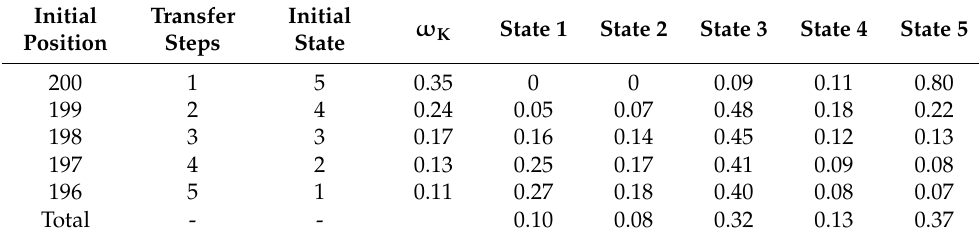
Table 7. State prediction of the sea clutter power of the latter position.